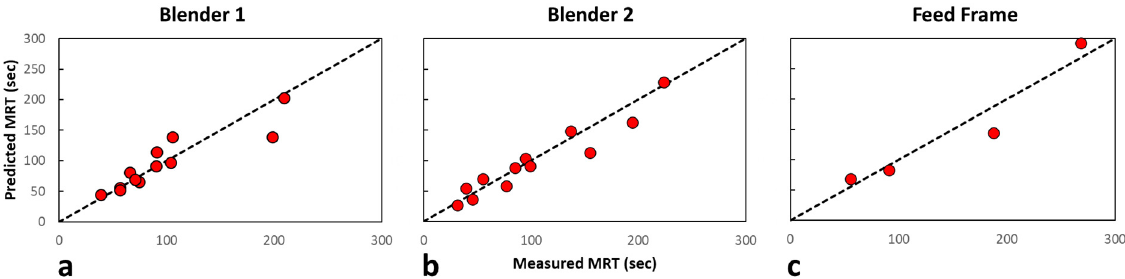
Figure 11. Parity plots for each blending unit comparing the measured and predicted mean residence time. ( a ) Blender 1 parity plot of the measured versus predicted mean residence time. ( b ) Blender 2 parity plot of the measured versus predicted mean residence time. ( c ) Feed frame parity plot of the measured versus predicted mean residence time. Table 5. Regressed Blender Constants for Each Blending